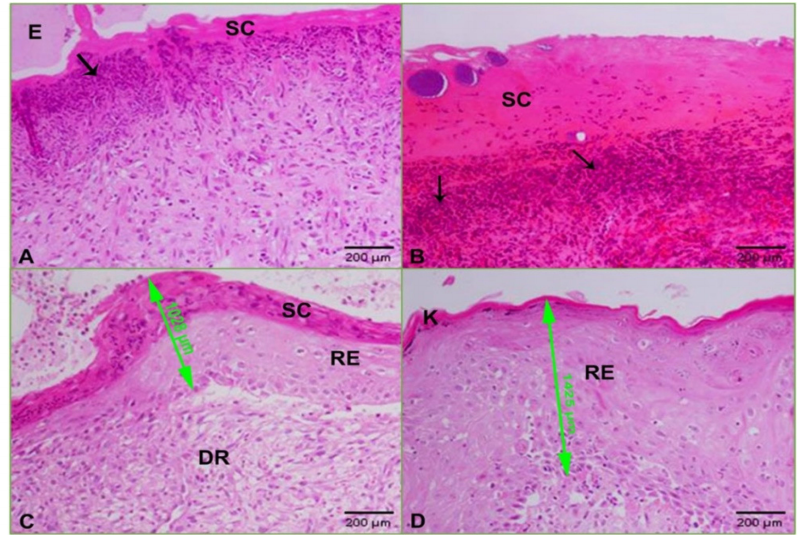
Figure 9. Photomicrographs of skin at day 14 after wounding: ( A ) uninfected and untreated wounded skin showing a scab ( SC ), granulomas (arrow), and edema ( E ); ( B ) infected and untreated wounded skin revealing a wide scab ( SC ) under which were granuloma (arrows) and hemorrhage; ( C ) infected and wounded skin treated with ZnO-NPs displaying a scab ( SC ) under which was regenerated epithelia (green arrow) of 1028 µ m followed by regenerated dermis ( DR ); ( D ) infected and wounded skin treated with imipenem showing regenerated skin covered with a keratinized layer ( K ) of the thickened regenerated epidermis of 1425 µ m (green arrow) (HE: 200 ×